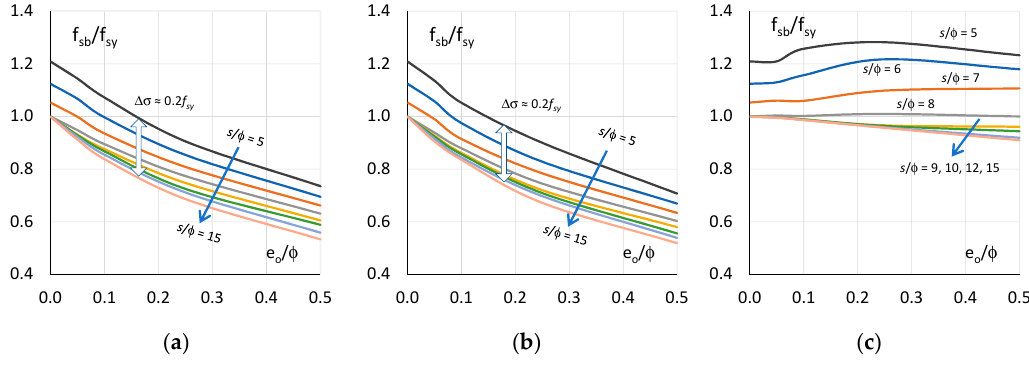
Figure 9. Normalized buckling resistance—amplitude of imperfection curve for: ( a ) bending deformation (MD), ( b ) compression deformation (ND) and ( c ) shear deformation (VD).